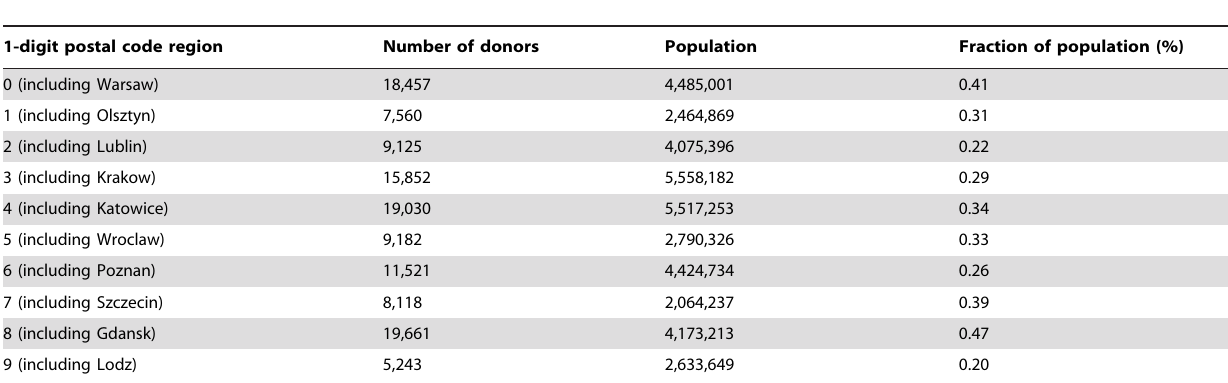
Table 1. Regional distribution of study donors ( n =123,749) and population figures of Polish 1-digit postal code regions as of June 30,